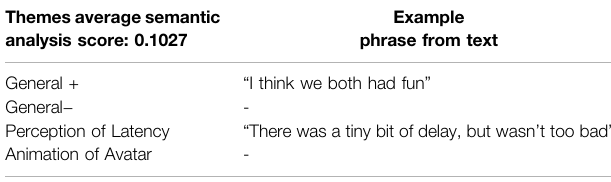
TABLE 4 | Cluster 2.